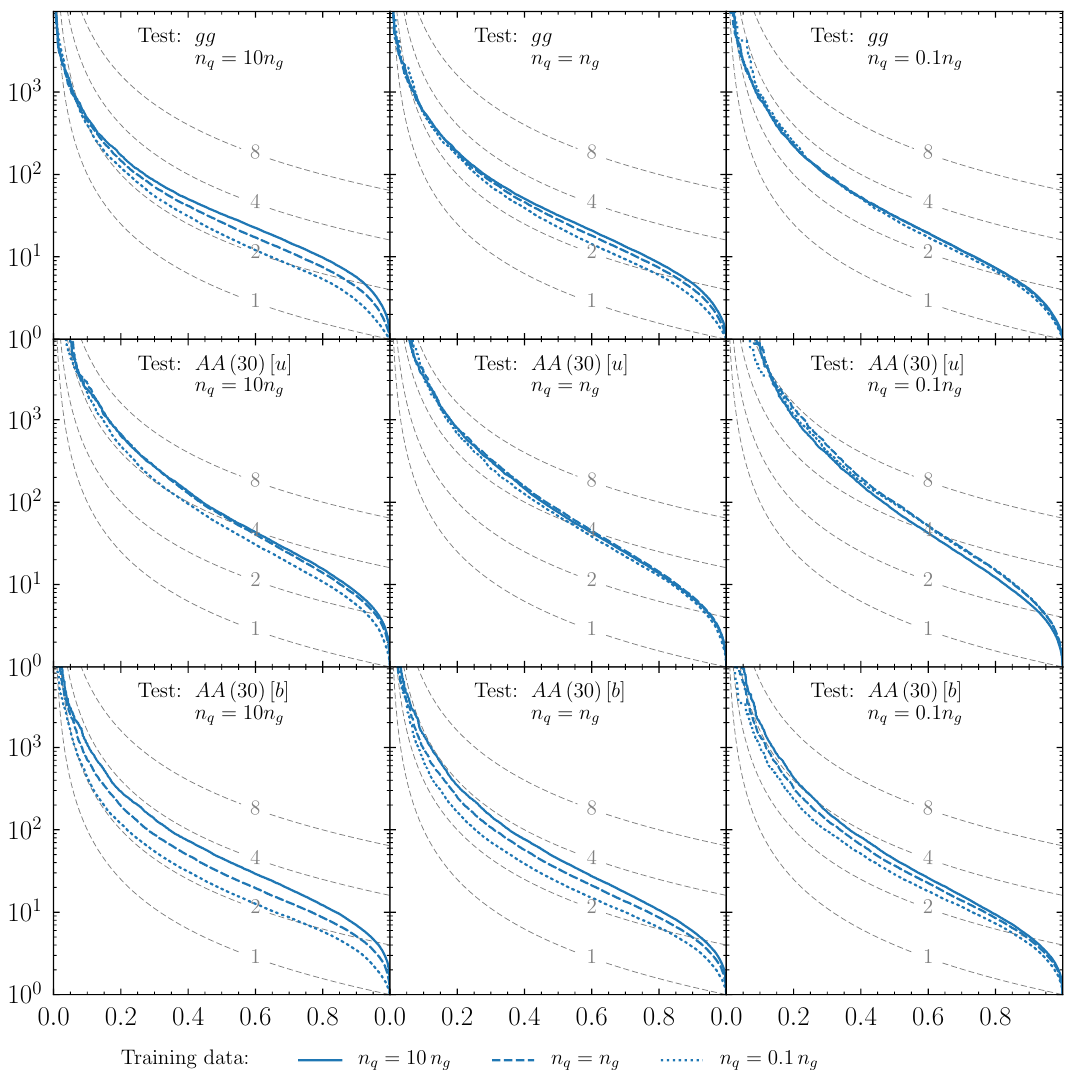
Figure 9 . E(cid:11)ect of QCD quark to gluon ratio in training and test data. The performance of the di(cid:11)erent taggers (solid, dashed and dotted lines) is shown for several signals (in rows) and for di(cid:11)erent choices of quark to gluon ratios in the background test data (in columns).